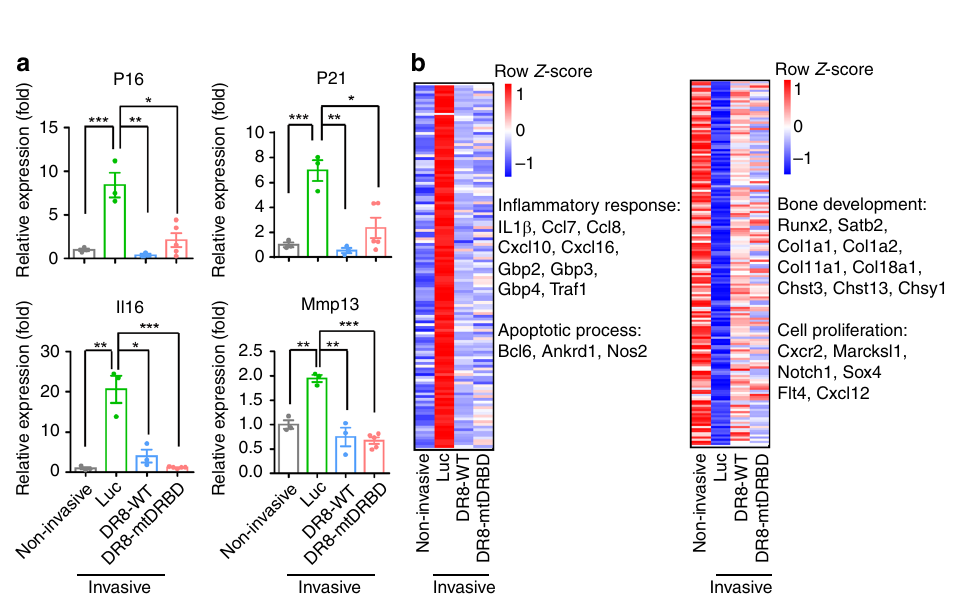
Fig. 8 Aging and in fl ammation factors dysregulated in mouse osteoarthritis are rescued by DGCR8 overexpression. a Quantitative RT-PCR analysis of P16, P21, Il6 and Mmp13 in non-invasive mouse ( n = 3 mice) joints and ACLT joints treated with lentiviruses expressing Luc ( n = 3 mice), DR8-WT ( n = 3 mice) or DR8-mtDRBD ( n = 5 mice). Data were presented as mean ± SEM. * p < 0.05, ** p < 0.01, *** p < 0.001. b Left, heatmap showing Z-score normalized expression levels of downregulated genes in non-invasive mouse joints and ACLT joints treated with lentiviruses expressing DR8-WT or DR8-mtDRBD, compared with ACLT joints treated with lentiviruses expressing Luc. Right, heatmap showing Z-score normalized expression levels of upregulated genes in non-invasive mouse joints and ACLT joints treated with lentiviruses expressing DR8-WT or DR8-mtDRBD, compared with ACLT joints treated with lentiviruses expressing Luc. The downregulated and upregulated genes were listed in Supplementary Data 7. Statistical signi fi cances were assessed by